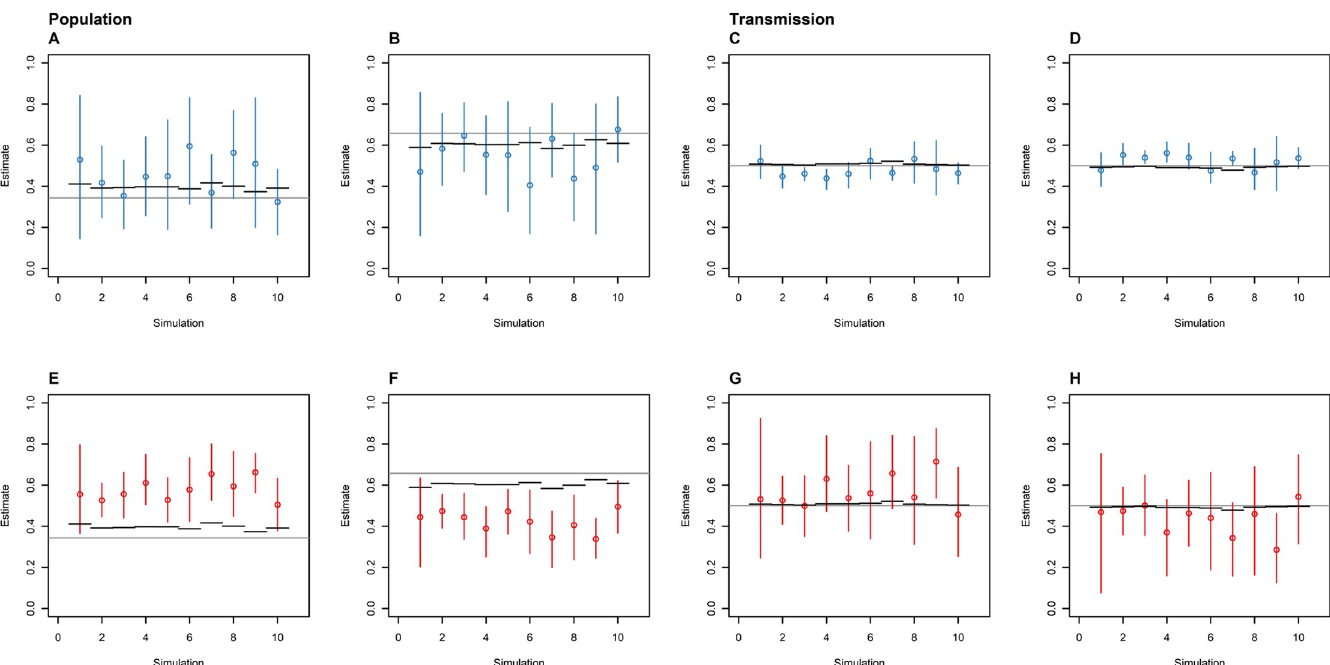
Fig 2. The proportion of time spent in the animal (A and E) and human (B and F) host populations, and the proportion of inter-population transmissions made up of animal-to-human (C and G) and human-to-animal (D and H) transmissions as estimated by the SC (blue: A-D) and DTA (red: E-F) models, for 10 random samples of the same simulated outbreak. The circles represent the mean, the error bars represent the 95% HPD interval, the black horizontal lines represent the known parameters for the sampled outbreaks, and the grey horizontal lines represent the known parameters for the entire outbreak.